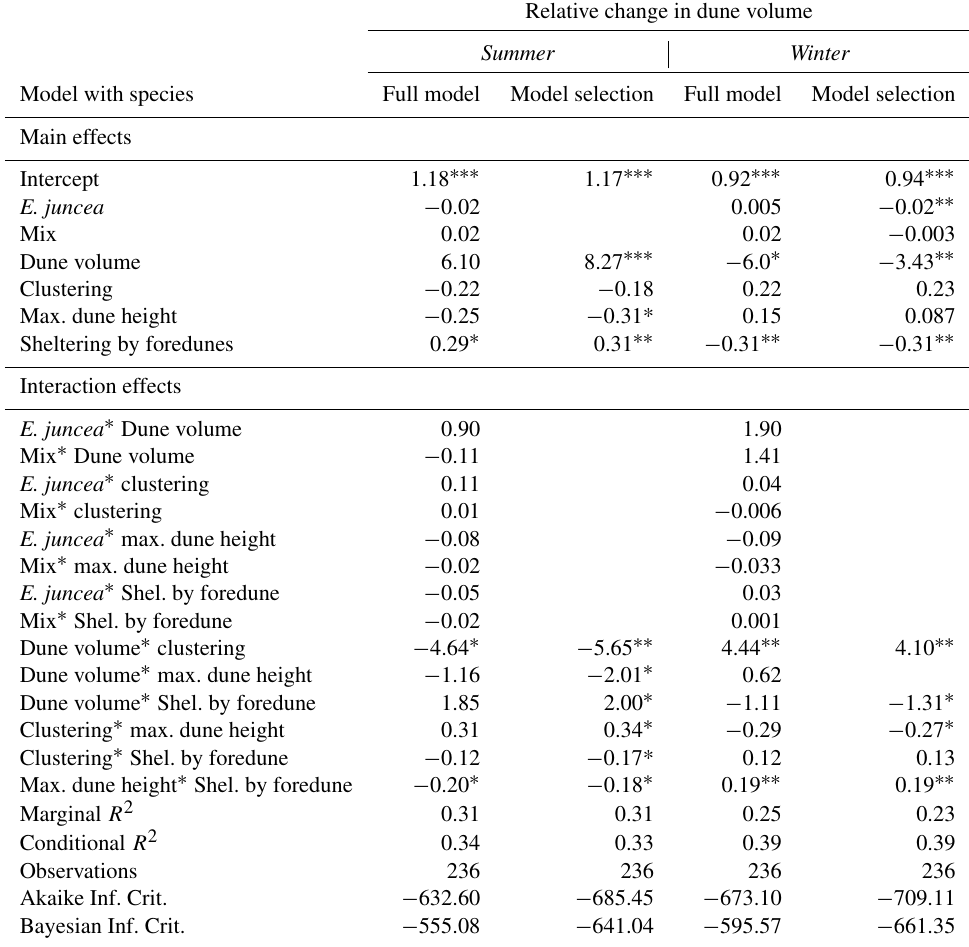
Table 1. Statistical models for the relative change in dune volume between April–August (summer) and November–April (winter) for nebkha dunes. In this model we tested the effect of species, dune size and degree of sheltering. The data were analysed with a general linear mixed model with blocks as random intercept. The standardized estimates and level of significance are shown for the models. Model selection was performed with AIC as selection criteria. Marginal R 2 is the variation explained by the fixed factors, whereas the conditional R 2 is the variation explained by the fixed and random